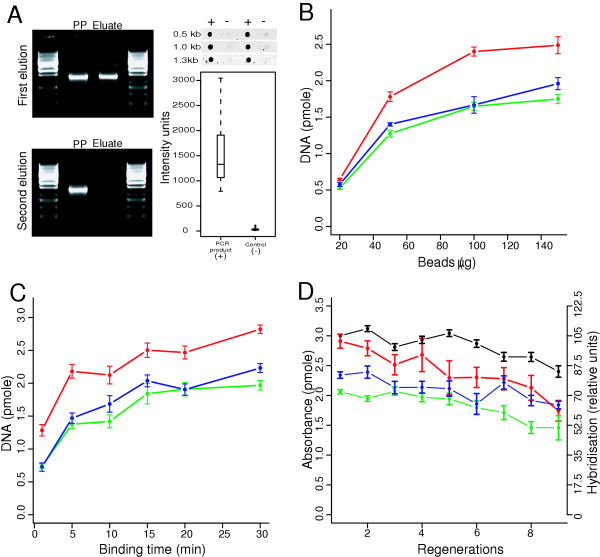
Solid-phase purification parameters. In A the agarose gel image shows the first (upper left image) and second (bottom left image) elution of the captured 1.0 kb product. The first and fourth lanes contain a size marker, while the second and third lanes contain an equal amount, assuming 100% yield at purification step, of unpurified PCR product (PP) and purified PCR product (eluate), respectively. The images on the right shows the results from the carry-over test, where PCR product and water were used as input samples for multiple consecutive purification reactions in an alternating order. The upper part shows the hybridisation results (PCR product, water, PCR product and water), while the box-and-whiskers plot below shows the quantifications of the signals (n = 18, six replicates of the three different products). Purification of three amplification products (red line 0.5 kb, green line 1.0 kb and blue line 1.3 kb) is investigated using an increasing amount of streptavidin-coated magnetic beads (number of independent replications, n = 8, panel B), varying binding time (n = 4, panel C) and repeatedly used beads (n = 4, panel D). The black line in (D) is based on fluorescence data and is plotted using the y-axis on the right, while the three other lines are based on absorbance measurements and use the y-axis on the left side. The presented data originates from repeated independent experiments and the error bars denote the calculated standard error.